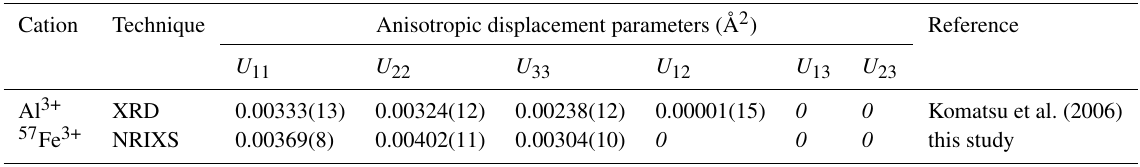
Note that standard deviations on the last digit are given in parentheses. Values in italics were fixed during